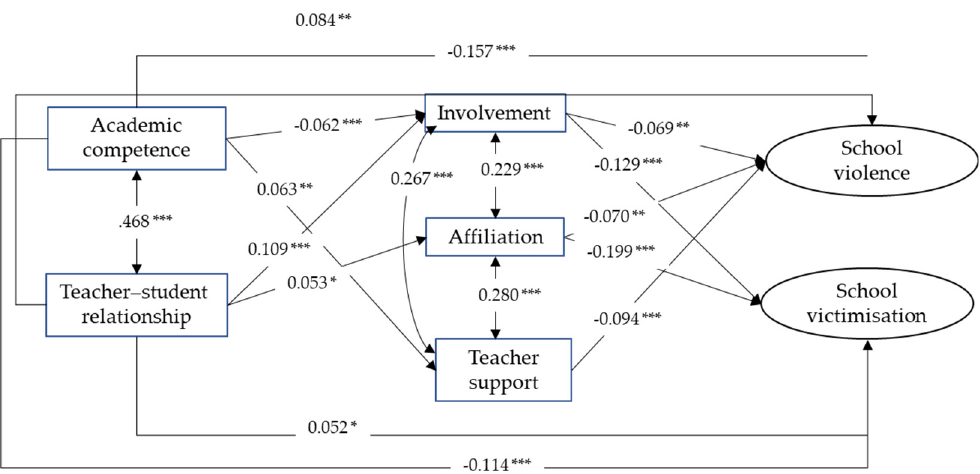
Figure 1. Final structural model with path coefficients and statistical significance. *** p < 0.001; ** p < 0.01; * p < 0.05.